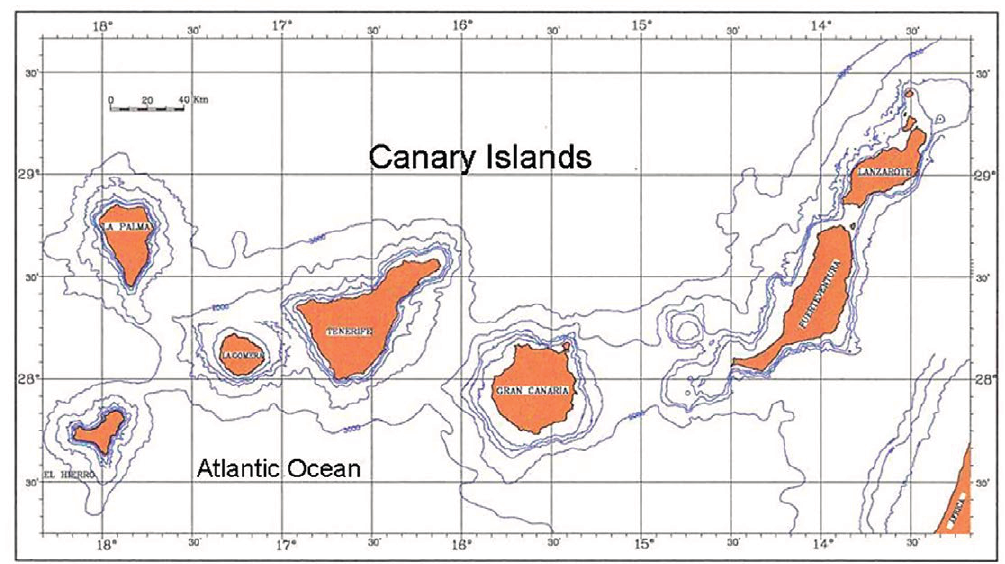
Fig. 1. – Map of the Canary Islands (central-east